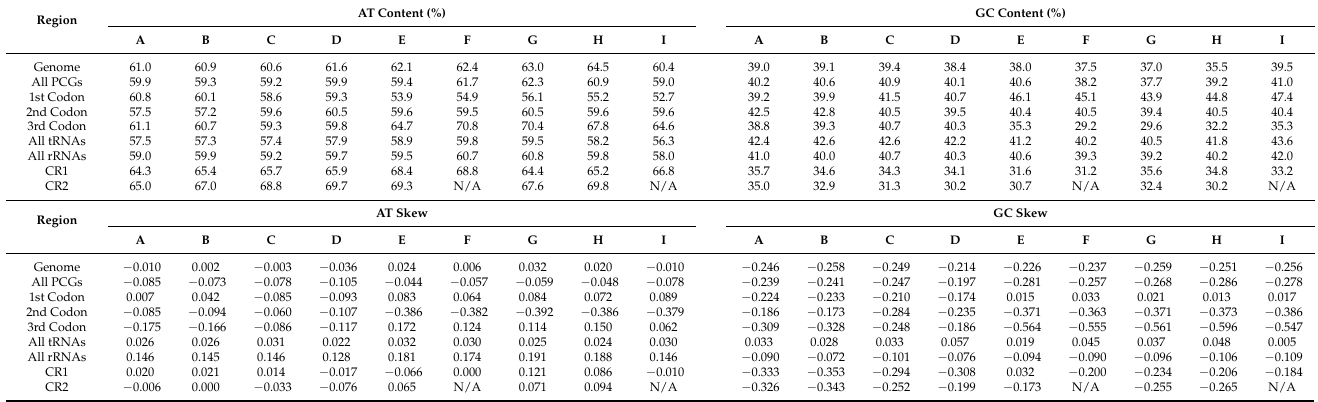
Table 2. Mitogenome nucleotide composition and skewness of nine